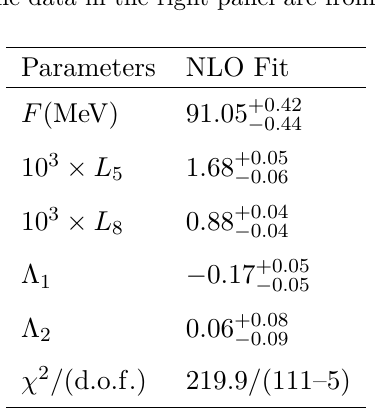
Figure 3 . The pion-mass dependences of F π , F K and m K . The lattice data in the left and central panels are from refs. [60, 61]. The data in the right panel are from ref. [62].